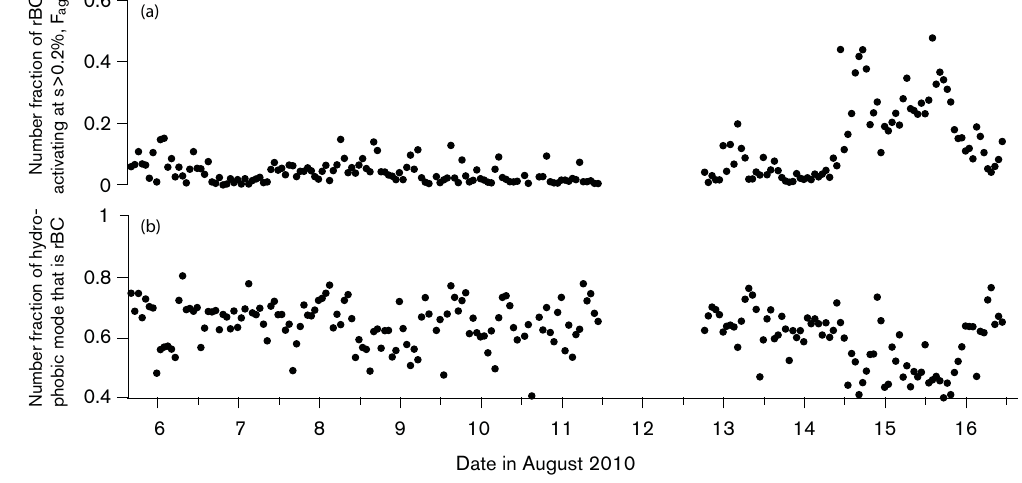
Fig. 7. Number fraction of rBC-containing particles that are CCN active at a supersaturation 0.2% for mixed particle dry mobility diameters of 193nm as a function of time (a) and the number fraction of 193nm non-CCN active particles that contain rBC (b) observed during the ambient Manchester sampling between 5 and 16 August 2010. Only periods when the HTDMA-SP2 system was operating at 90% RH are